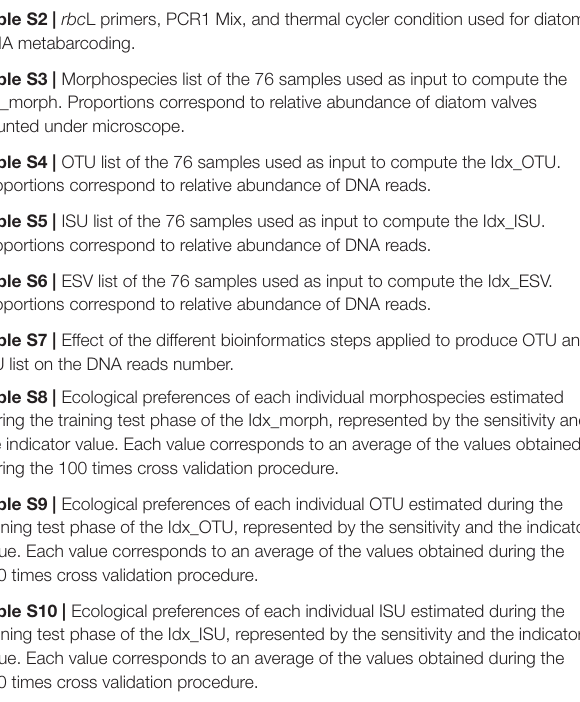
Table S2 | rbc L primers, PCR1 Mix, and thermal cycler condition used for diatom DNA metabarcoding. Table S3 | Morphospecies list of the 76 samples used as input to compute the Idx_morph. Proportions correspond to relative abundance of diatom valves counted under microscope.